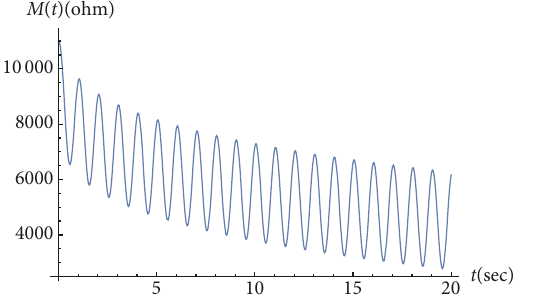
Figure 15: 𝑀(𝑡) of the fractional order memristor under the sinusoidal input with 𝐼 𝑚 > 0: 𝛼 = 1.25 .